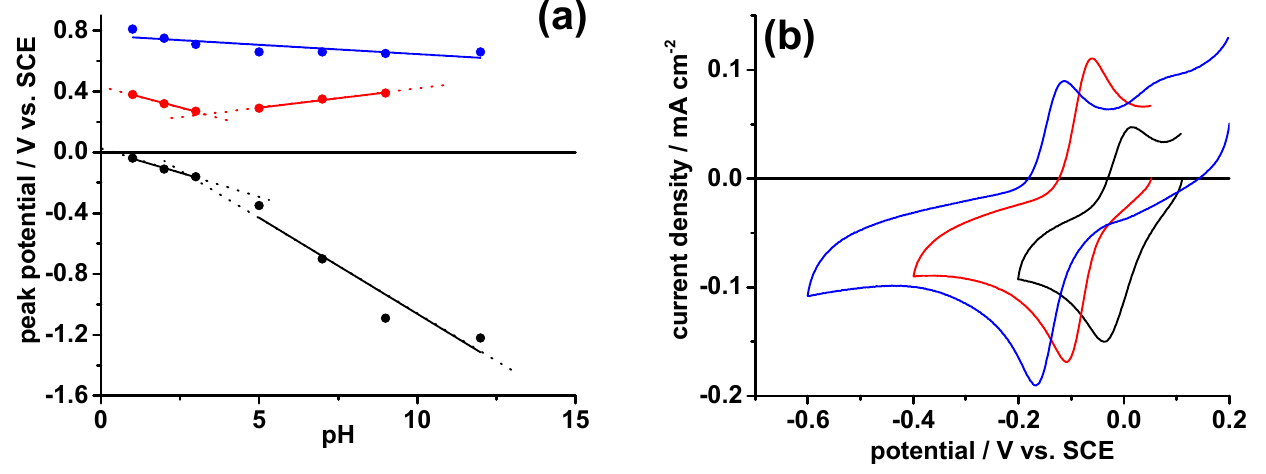
Figure 4. ( a ) The linear relationships of oxidation (E ox1 red line, E ox2 blue line) and reduction (black line) peak potentials of N-CDs-160-8 versus pH. ( b ) Cyclic voltammograms of N-CDs-160-8 in pH 1 (black line), pH 2 (red line) and pH 3 (blue line) buffers + 0.1 M NaClO 4 . Scan rate: 0.1 V s − 1 .